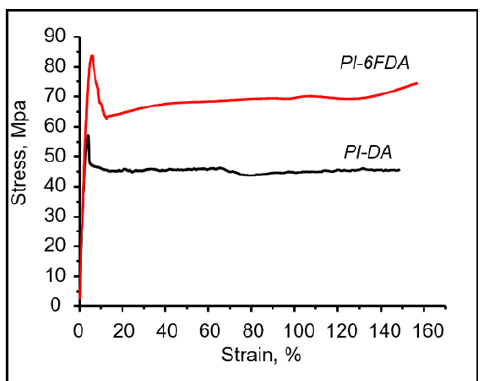
Figure 4. Typical stress-strain curves at room temperature of film cast from chloroform PI-DA and PI-6FDA (elongation rate of 5 mm/min).